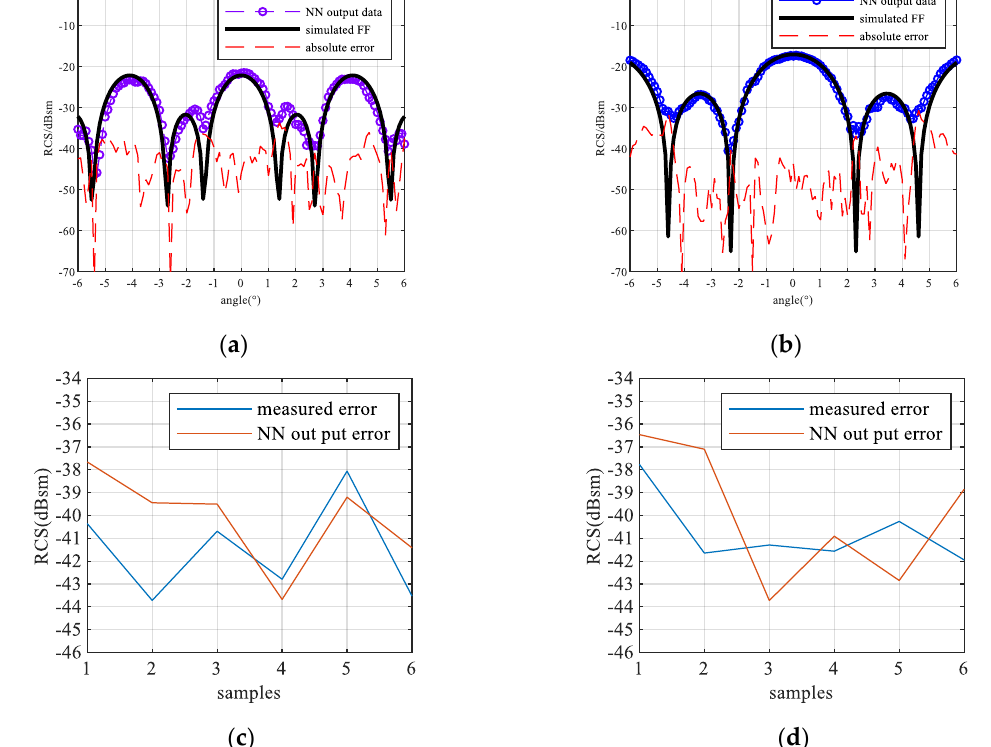
Figure 15. Result and RMSE output by improved NN: ( a ) Sphere diameter = 25 mm (0.83 λ ), R = 0.21 m (7 λ ) NN output result; ( b ) Sphere diameter = 45 mm (1.5 λ ) R = 0.125 m (4.16 λ ) NN output result; ( c ) RMSE of each sample for 25 mm (1.5 λ ) diameter sphere; ( d ) RMSE of each sample for 45 mm (0.83 λ ) diameter sphere.